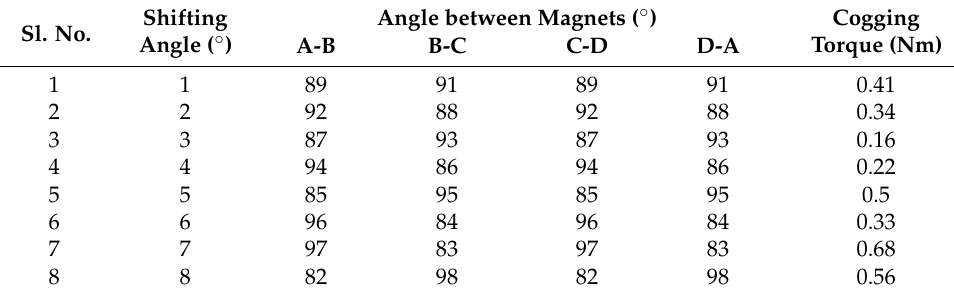
Figure 7. Rotor magnet shift from 1 ◦ to 8 ◦ . Table 5. Comparison of 3D FEA results for cogging